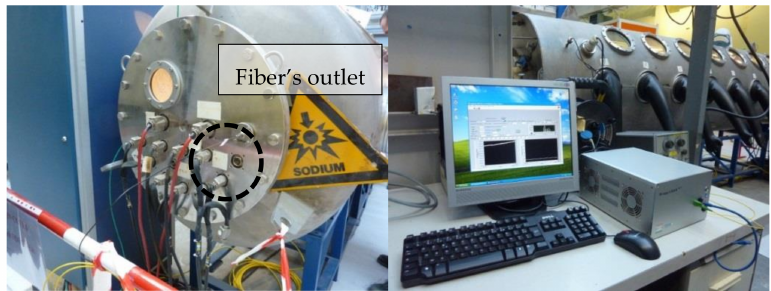
Figure 12. On the left, the CEA/Penelope glove box for testing of sensors in heated liquid sodium and on the right CEA LIST proprietary FBG monitoring system deployed nearby the Penelope facility located at CEA/Cadarache research